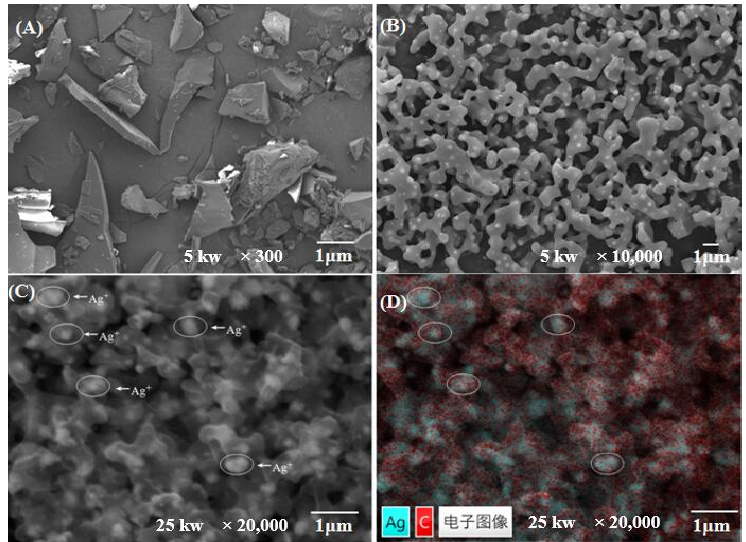
Figure 4. ( A ) FESEM image (×300, 5 kw) of compound 7a in the absence of Ag + . ( B ) FESEM image (×10,000, 5 kw) of compound 7a in the presence of Ag + . ( C ) FESEM image (×20,000, 25 kw) of compound 7a in the presence of Ag + . ( D ) Energy spectrum image (×20,000, 25 kw) of compound 7a in the presence of Ag + .